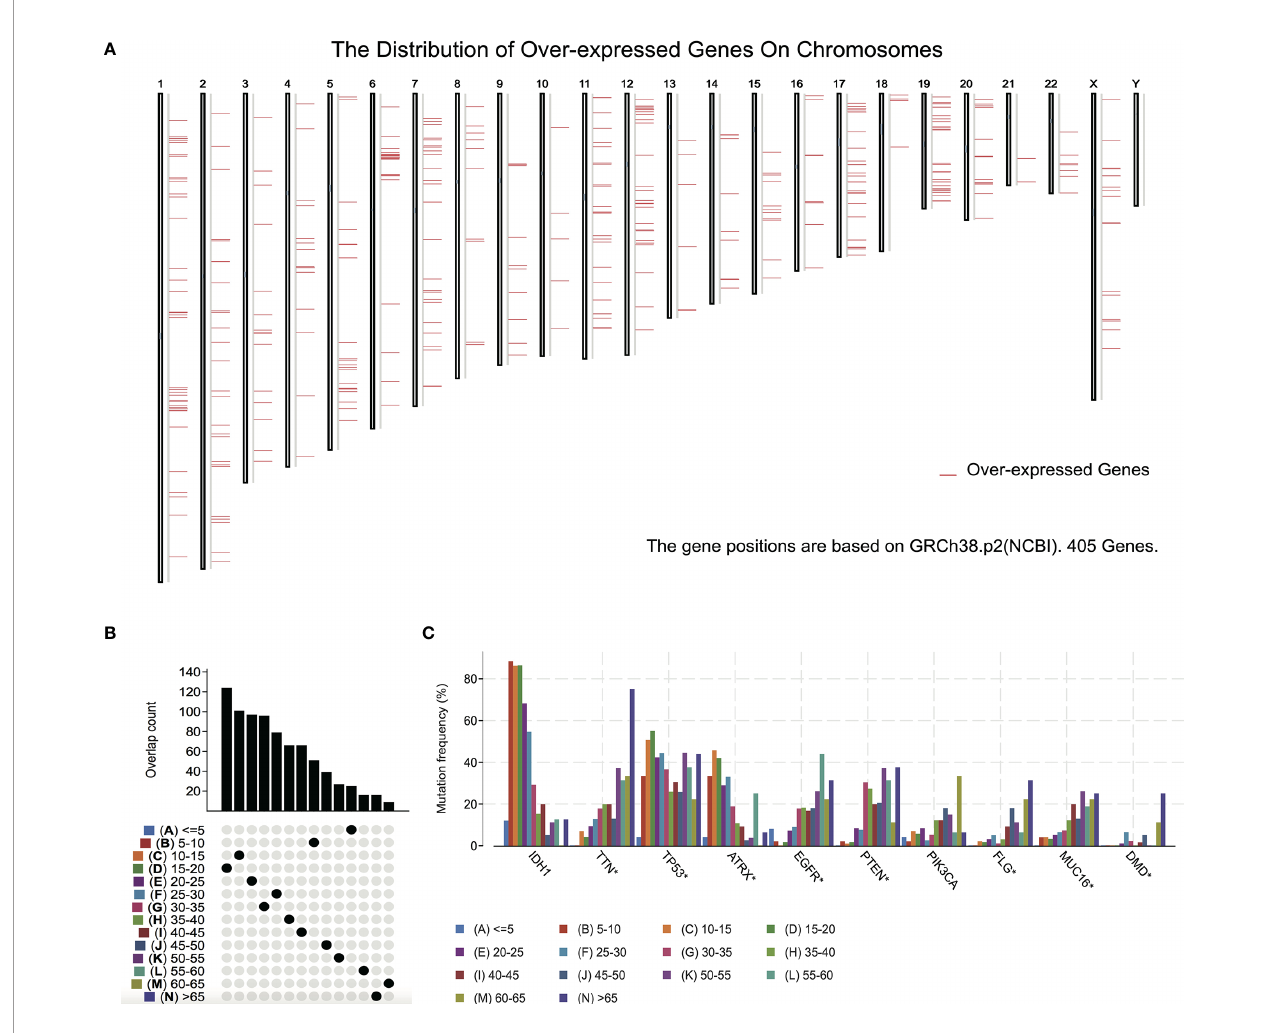
FIGURE 1 | Identi fi cation of potential tumor antigens of GBM. (A) Identi fi cation of potential tumor-associated antigens of glioma. Chromosomal distribution of overexpressed genes in glioma as indicated. (B, C) Identi fi cation of potential tumor-speci fi c antigens of glioma. (B) Samples overlapping in mutation count groups. (C) Genes with the highest frequency in mutation count